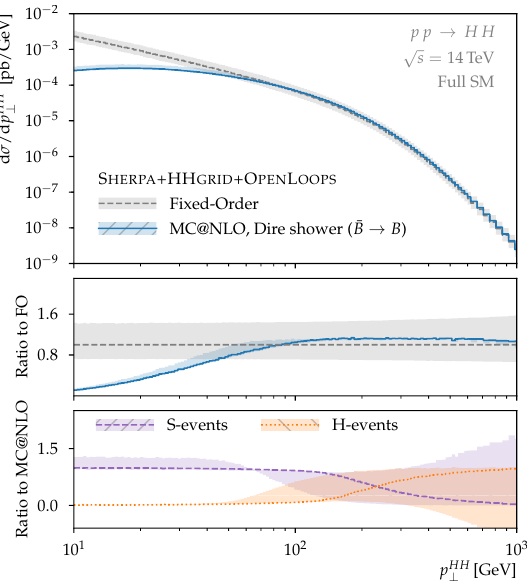
Figure 6 . Parton shower e(cid:11)ects on the p HH spectrum in a modi(cid:12)ed MC@NLO simulation where ? we replaced the S-event di(cid:11)erential seed cross section (cid:22) B by B . The uncertainty band around the (cid:12)xed-order result is obtained through variations of (cid:22) F and (cid:22) R . Uncertainties on the MC@NLO predictions are obtained by varying (cid:22) PS .